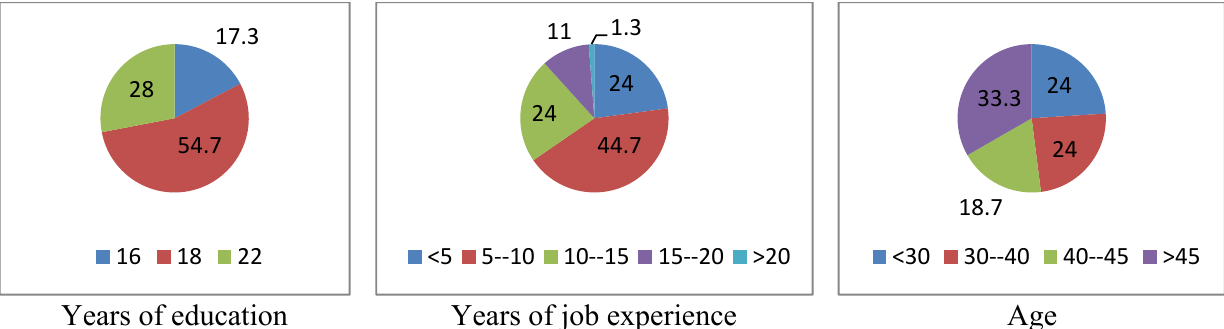
Fig. 1. Personal characteristics of the